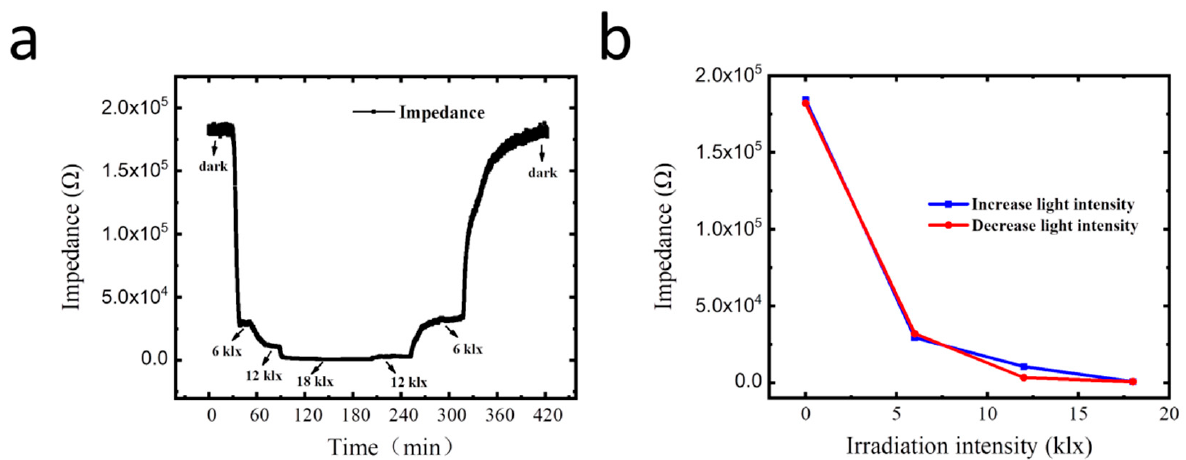
Figure 8. ( a ) Impedance variation of the GO-based sensor attached to a leaf surface as response to light intensity over time; ( b ) measurements of the sensor attached to the lower surface of a leaf under different light irradiation intensities.